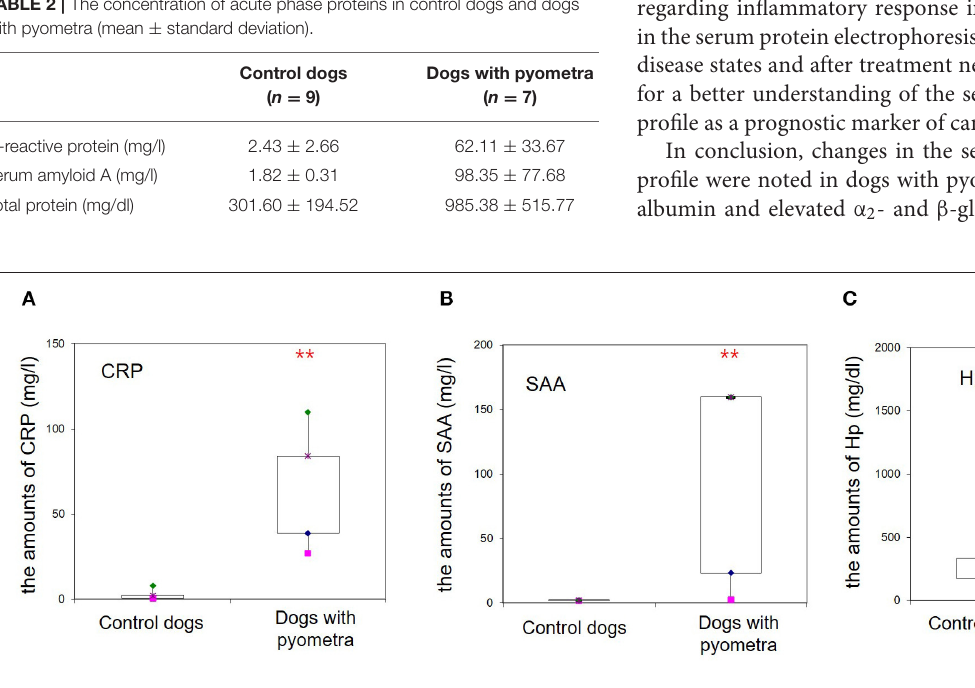
FIGURE 3 | Increased concentrations of acute phase proteins in dogs with pyometra. Significantly elevated levels of the C-reactive protein (A) , serum amyloid A (B) and haptoglobin (C) were observed in dogs with pyometra compared to the control dogs (** P <